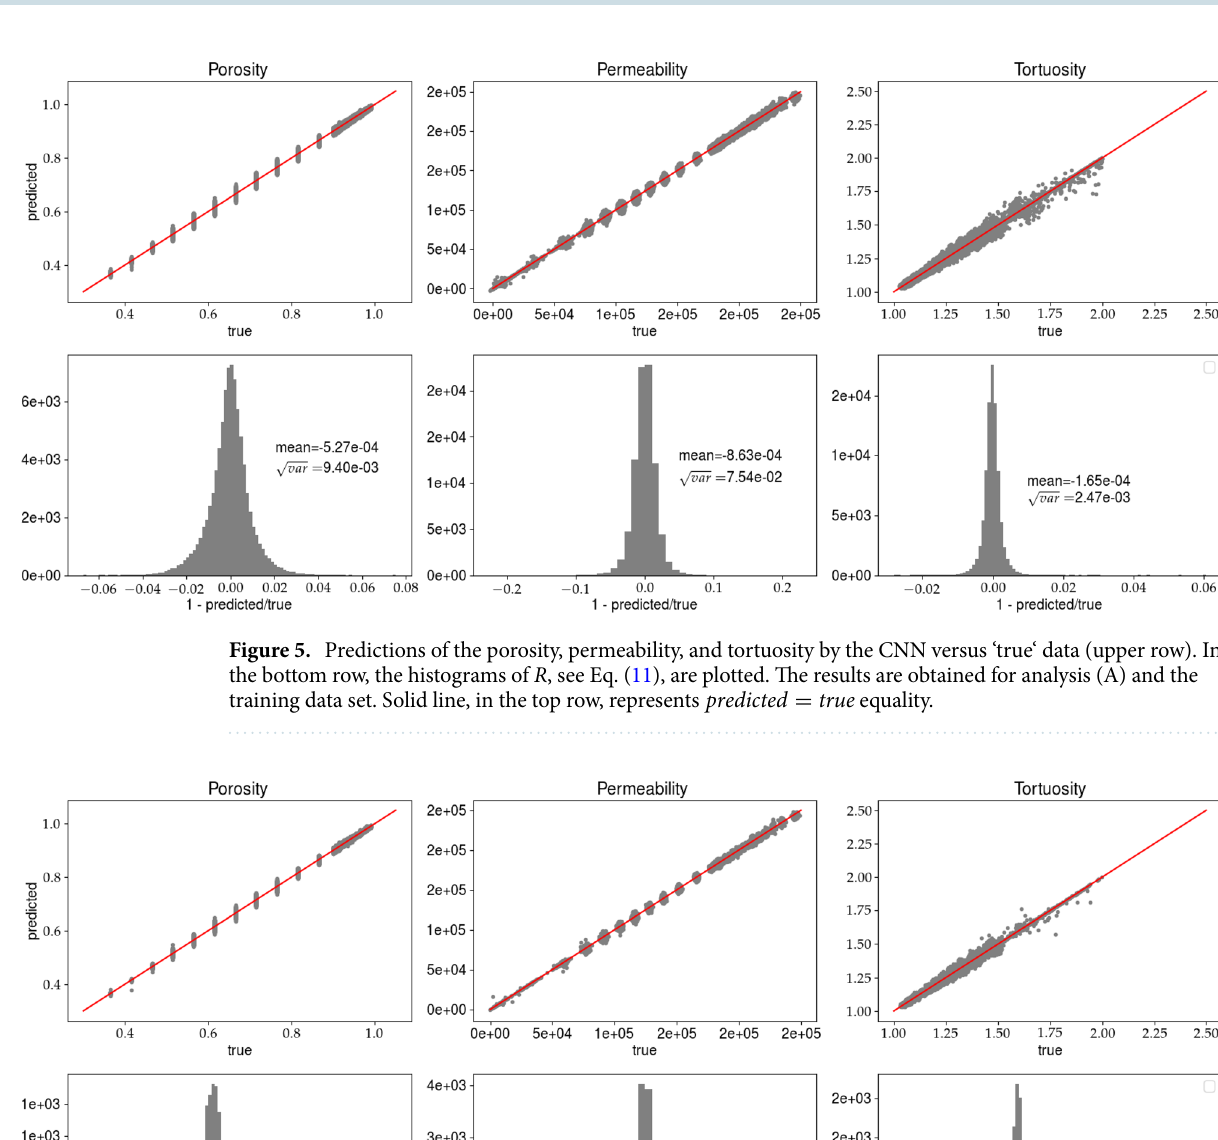
Figure 6. Caption the same as in Fig. 5 but the predictions are made for the validation data